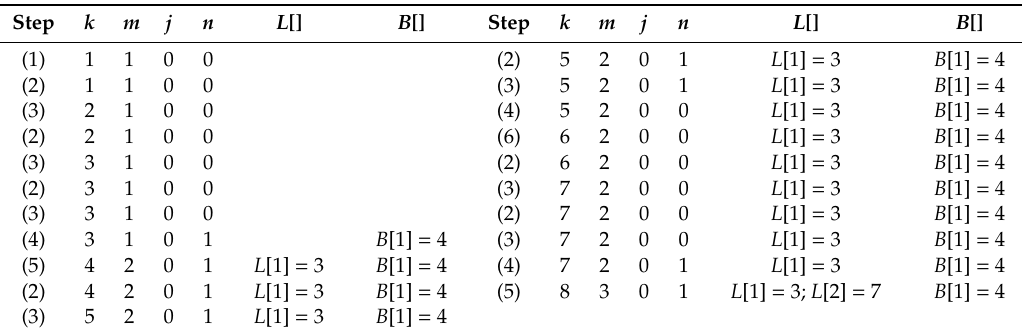
Figure 12. Iterative process of test case 4. Table 9. The operation steps of test case